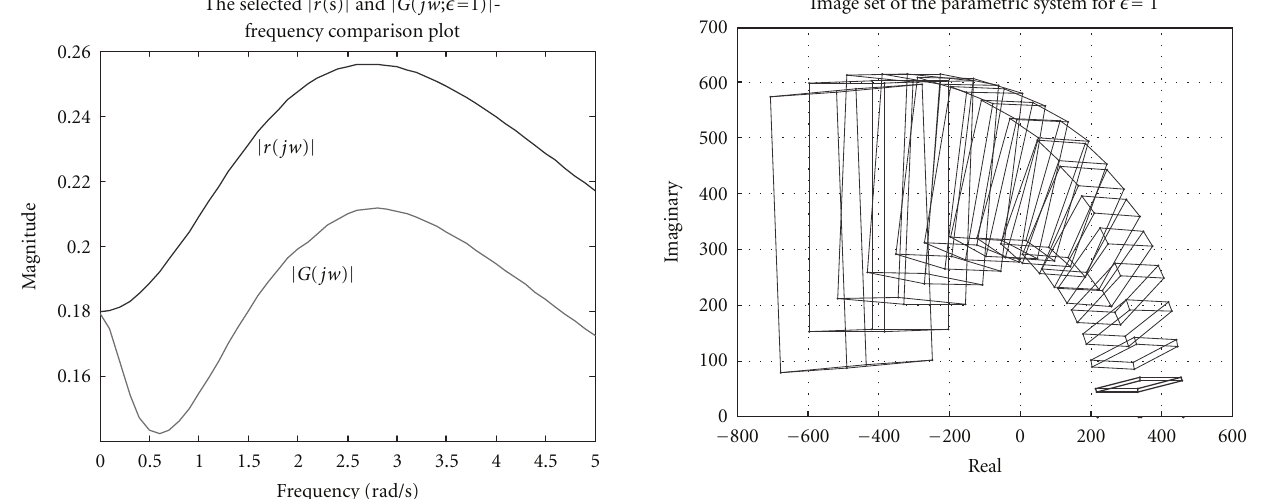
Figure 3: Kharitonov’s templates with ε 1 =